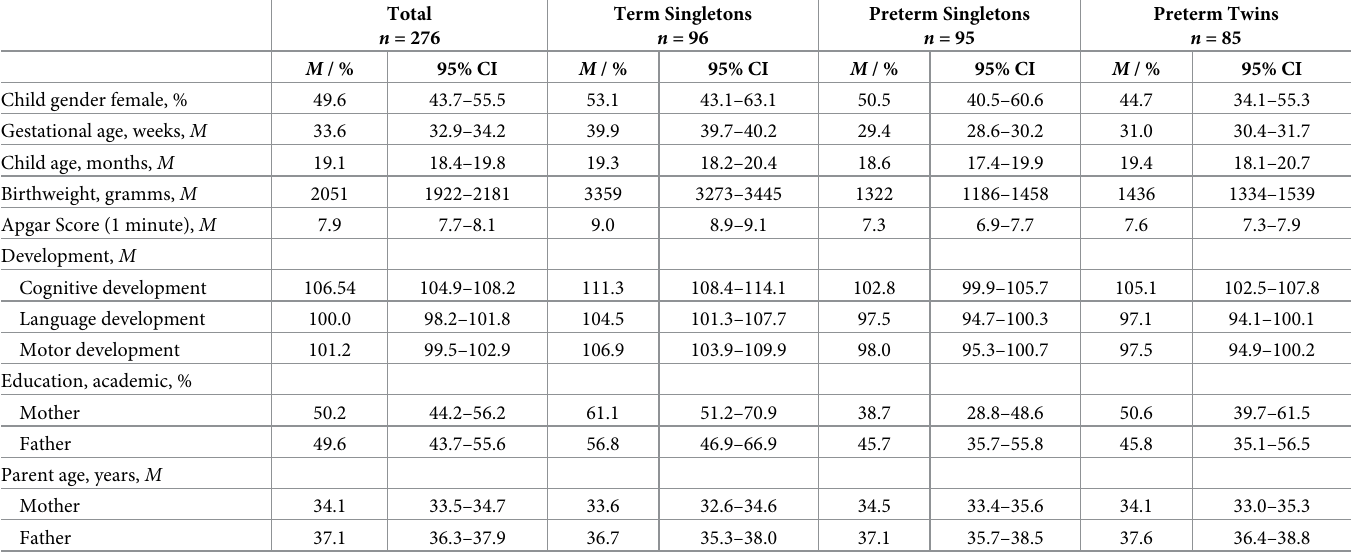
Table 1. Demographics of participating children subjected to the main analysis.